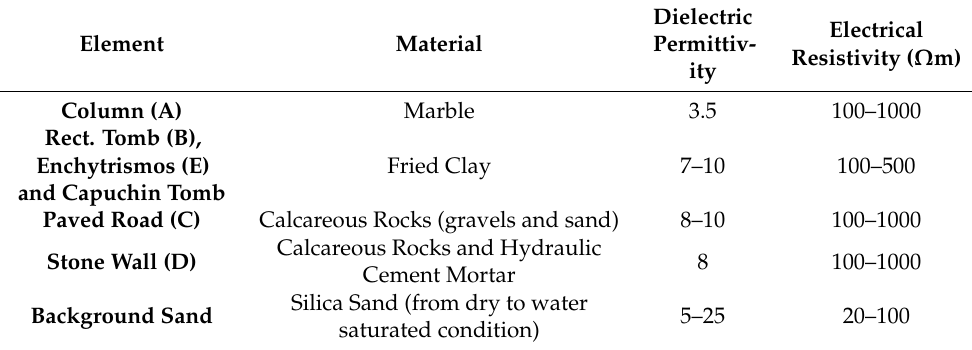
WP1: top of the shallower structures placed at 0.30 m from the original surface (Figure